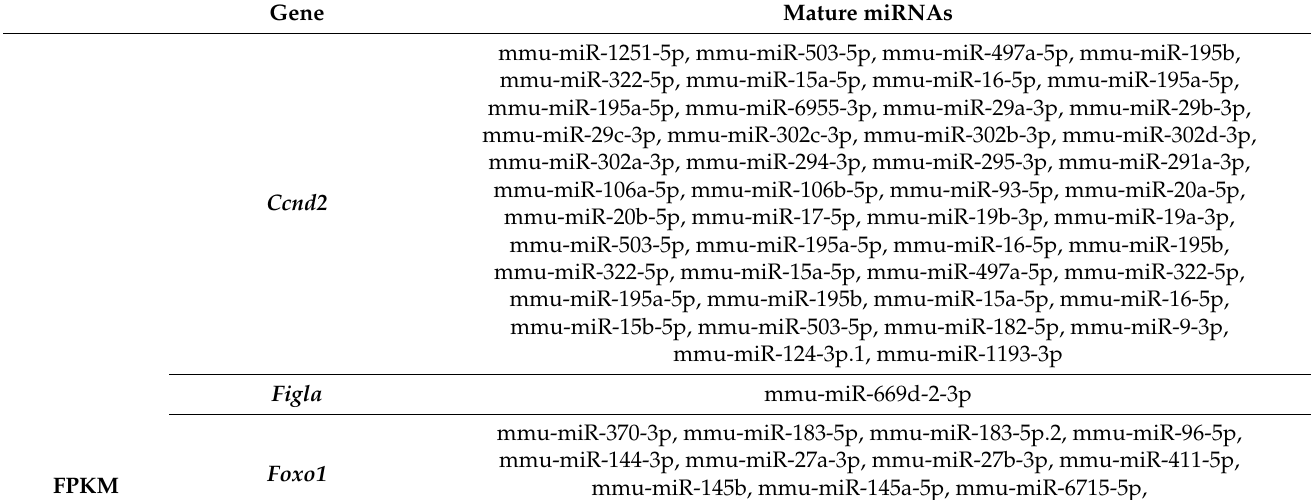
Table 5. Correlated miRNAs that interact with key target